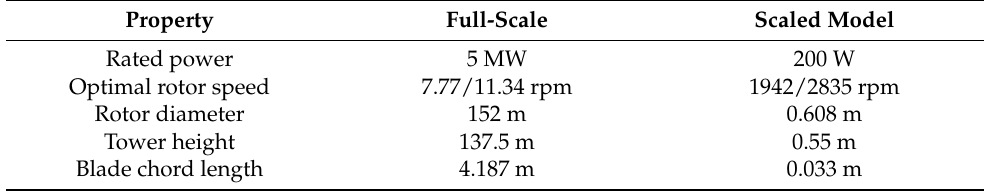
Table 2. Comparison of design parameters between scaled and full-scale wind